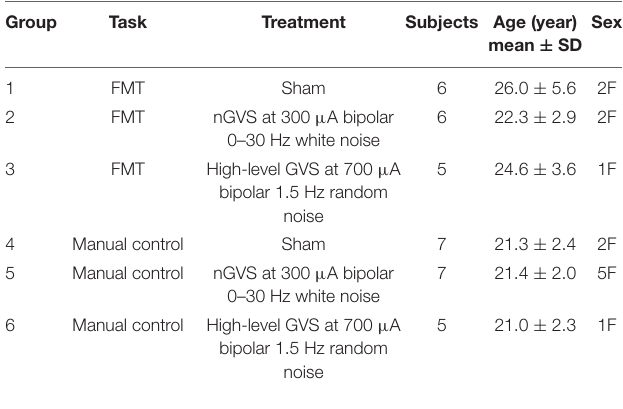
TABLE 1 | Summary of subject demographics and distribution amongst treatment groups.